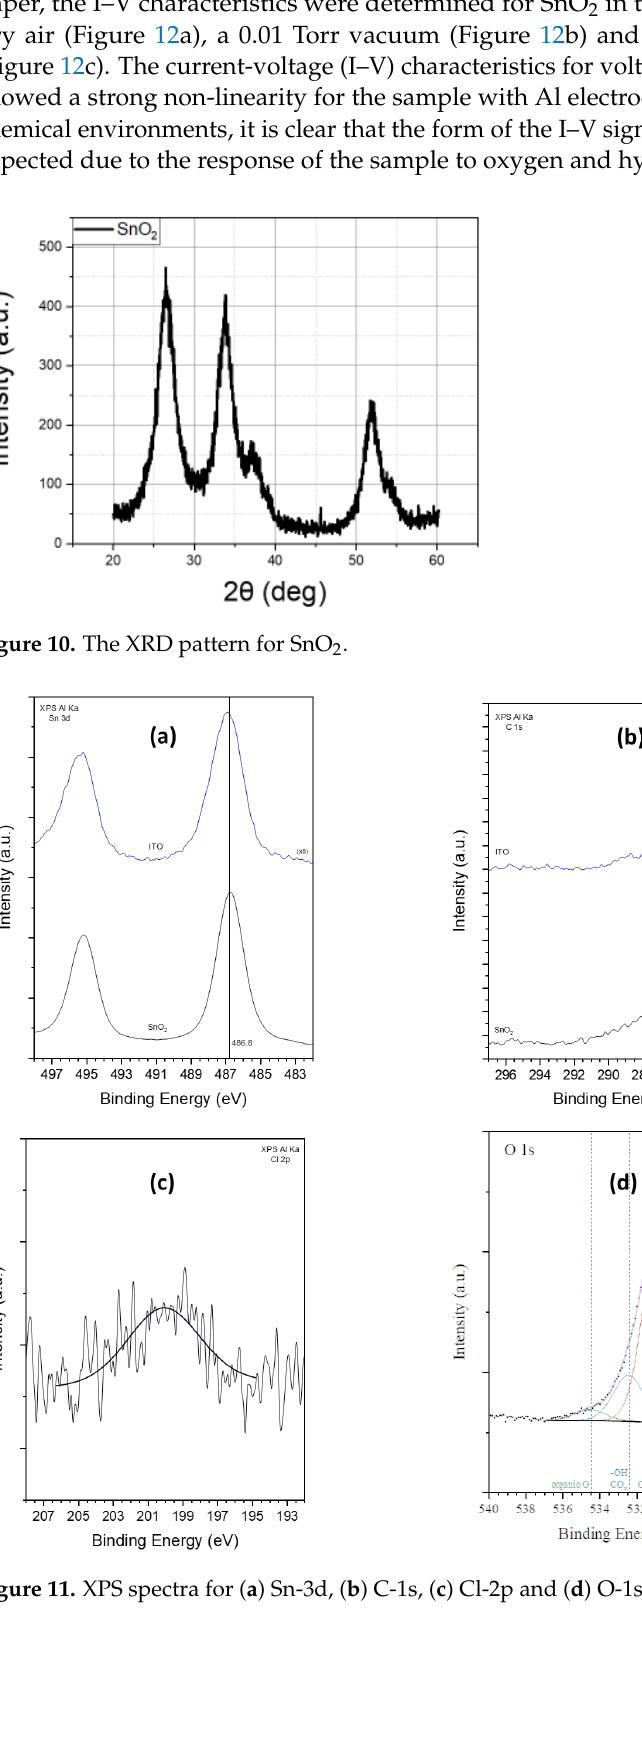
Figure 9. ( a ) The AFM of the side view, ( b , c ) the AFM from the top view from different scales and ( d ) the cross section of the undoped sample.